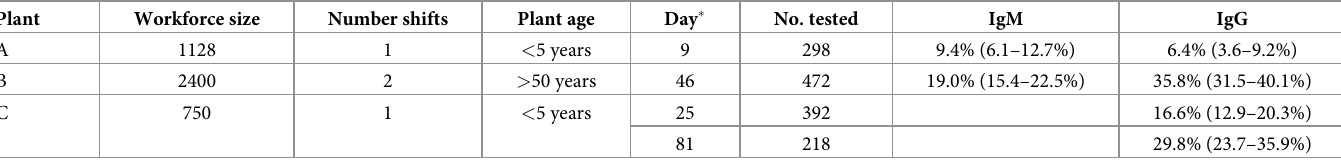
Table 1. Plant attributes and results of company-initiated